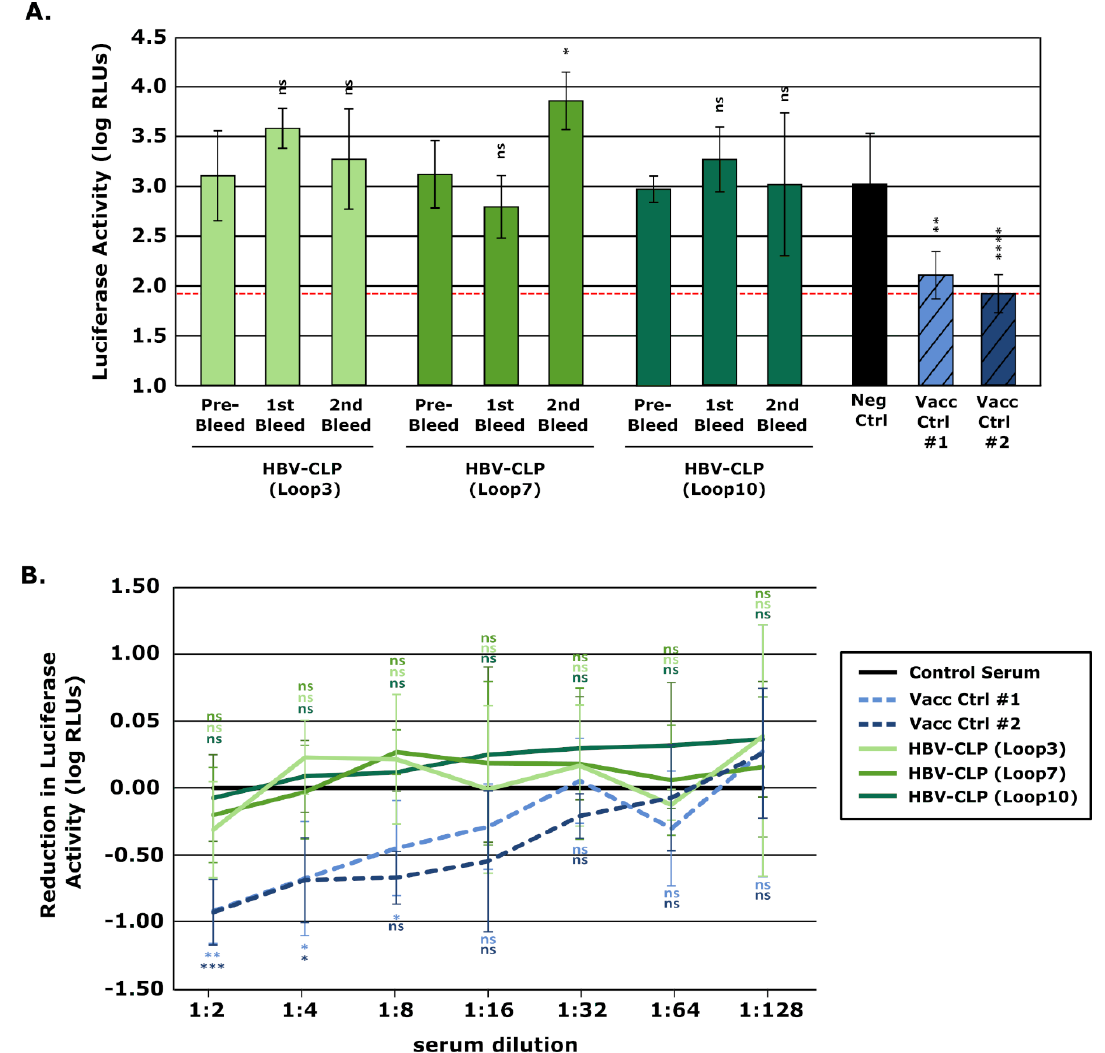
Figure 7. Assessment of neutralizing antibody development following vaccination with Hepatitis B virus core-like particles (HBV-CLPs) expressing Junín virus (JUNV)-derived peptides using neutral- ization of transcription and replication-competent virus-like particles (trVLPs). trVLPs containing the GP of JUNV (strain Romero) were incubated 1:1 (i.e., final 1:2 dilution) with serum from rabbits vaccinated with HBV-CLPs expressing 1 of 3 JUNV-derived peptides (i.e., Loop 3, Loop 7, Loop 10) collected before or during the immunization process, as indicated. Serum from human Candid#1 vaccinees (Vacc Ctrl) or a control pooled human AB serum served as additional controls. Samples were incubated for 2 h at 37 °C before being used to infect Huh7 cells pre-transfected with plasmids expressing JUNV NP and L. After 48 h, these cells were harvested and their nanoluciferase activity measured (as a measure of viral RNA synthesis). Data from at least two independent experiments are represented and the results of a one-way ANOVA comparison with control antibody-treated samples are shown. ( B ) Titration of neutralizing antibodies. Neutralization of trVLPs was performed as in ( A ) using the serum collected after the final immunization. The sera were prepared as a 1:2 dilution series before being added to trVLPs to achieve a dilution range from 1:2 to 1:128. Data from four independent experiments are represented and are shown relative to values obtained with the negative control sera (i.e., HBV-CLP-FLAG or human AB serum). The results of a one-way ANOVA comparing samples to the negative control serum are shown (ns not significant; * p ≤ 0.05; ** p ≤ 0.01; *** p ≤ 0.001; **** p ≤